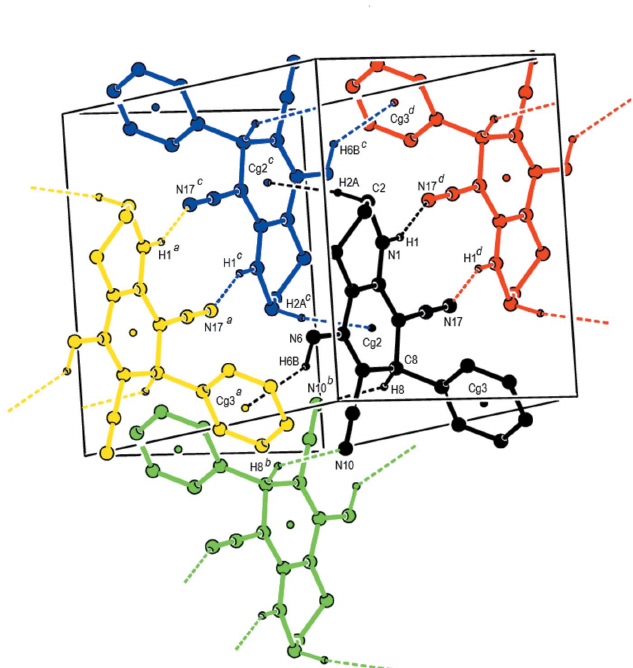
Figure 2 Aview of the N—H (cid:2)(cid:2)(cid:2) N, C—H (cid:2)(cid:2)(cid:2) N hydrogen bonds, C—H (cid:2)(cid:2)(cid:2) (cid:2) and N— H (cid:2)(cid:2)(cid:2) (cid:2) interactions in the extended structure of the title compound. The H atoms not involved in hydrogen bonding have been omitted for clarity.